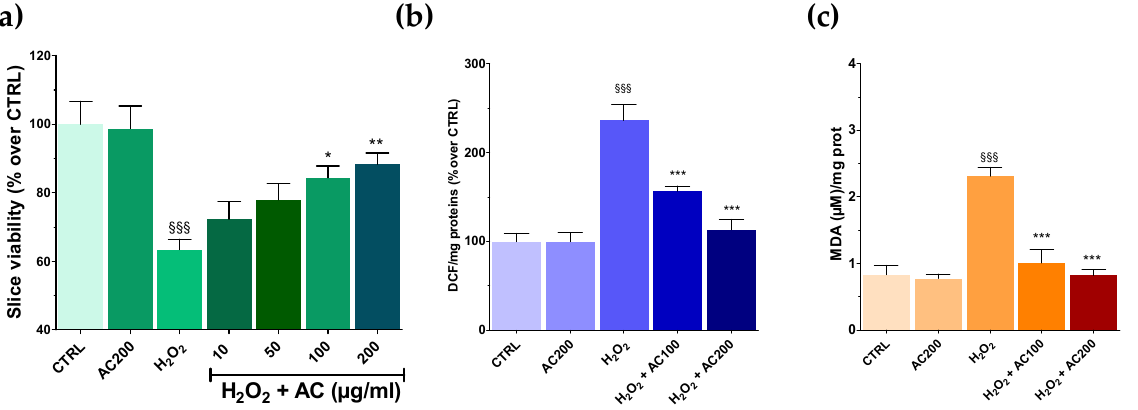
Figure 5. Effects of AC on OS-induced reduction in rat brain slices viability, formation of ROS, and malondialdehyde (MDA). Slices were incubated with artificial cerebrospinal fluid (ACSF) (controls) or ACSF + AC for 1 h. Afterward, AC was maintained and H 2 O 2 (5 mM, 1 h) was added. The effects of AC per se were tested at 200 µg/mL (AC200). ( a ) Viability was assessed by MTT assay. ( b ) ROS was evaluated by the oxidation of DCF-DA to DCF. ( c ) Thiobarbituric acid reactive substances formed as a by-product of lipid peroxidation detected using thiobarbituric acid and reported as MDA formed. Data are shown as means ± SEMs. §§§ p < 0.001, vs. untreated slices (CTRL); * p < 0.05, ** p < 0.01, *** p < 0.001 vs. H 2 O 2 (ANOVA followed by Bonferroni post hoc-test).